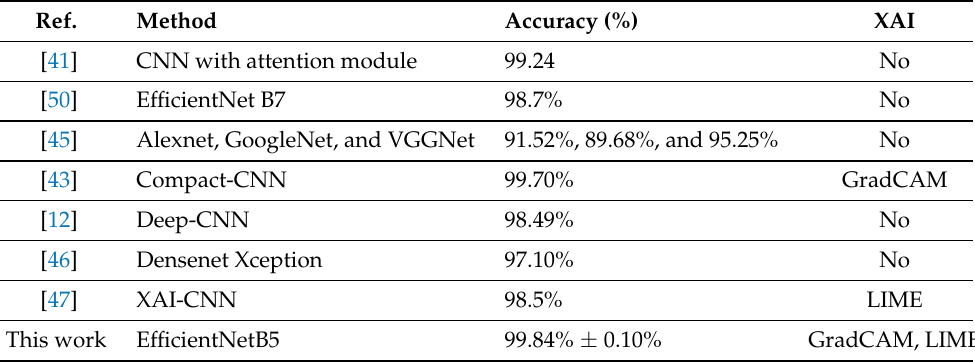
Table 6. Comparison of our model with the state-of-the-art methods on the TLD dataset.